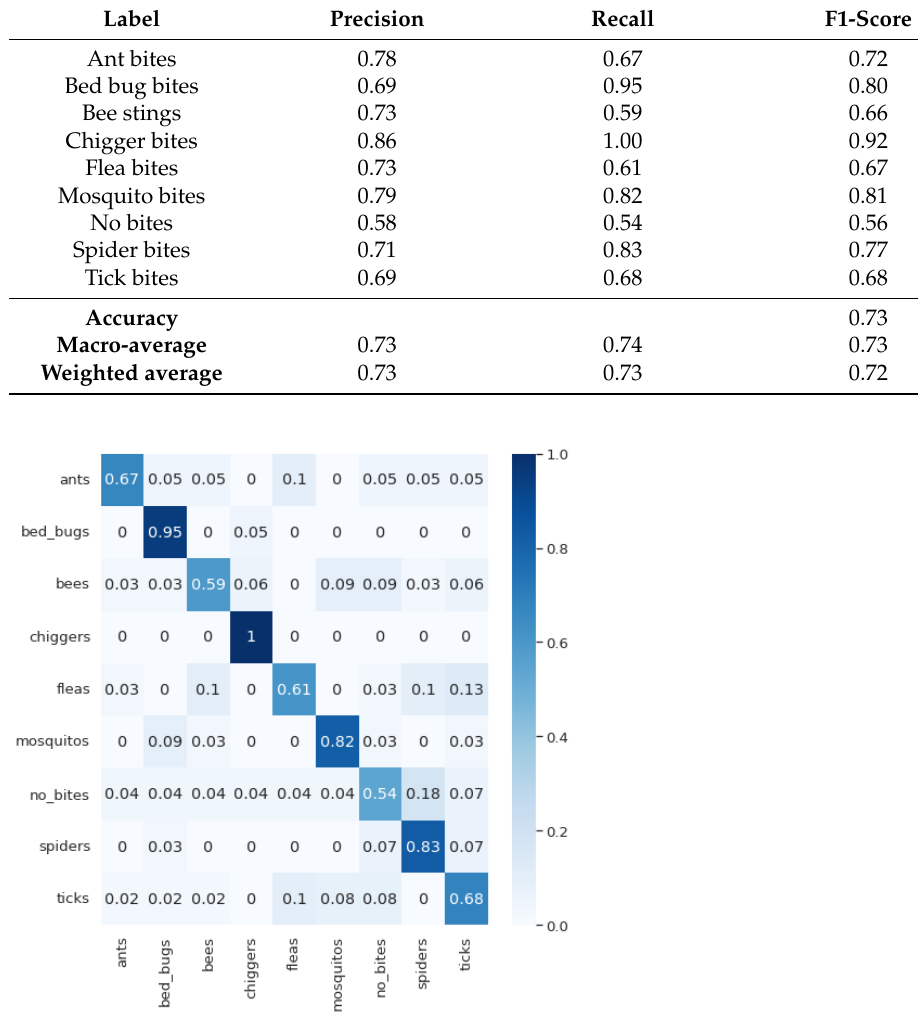
Figure 11. Normalized confusion matrix for